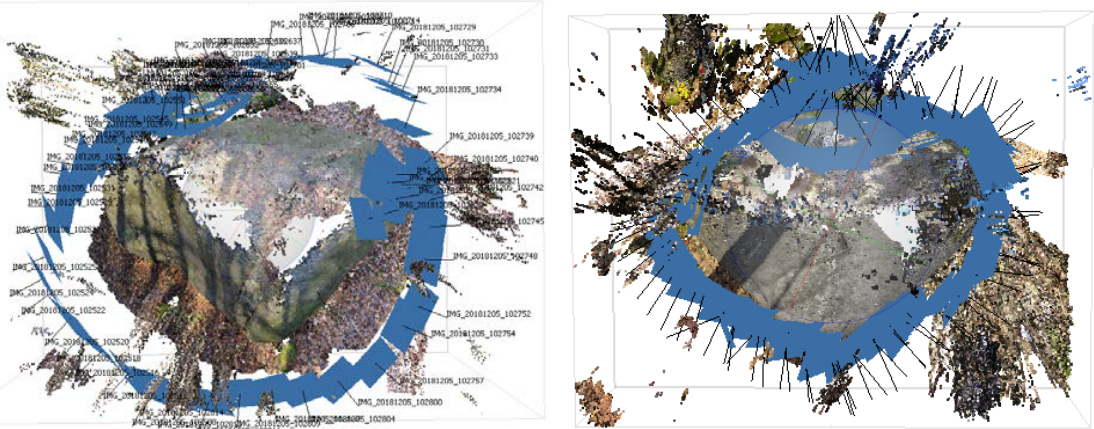
Figure 4. The camera’s selected geometry configuration for data acquisition (Boulder No.1 – left,